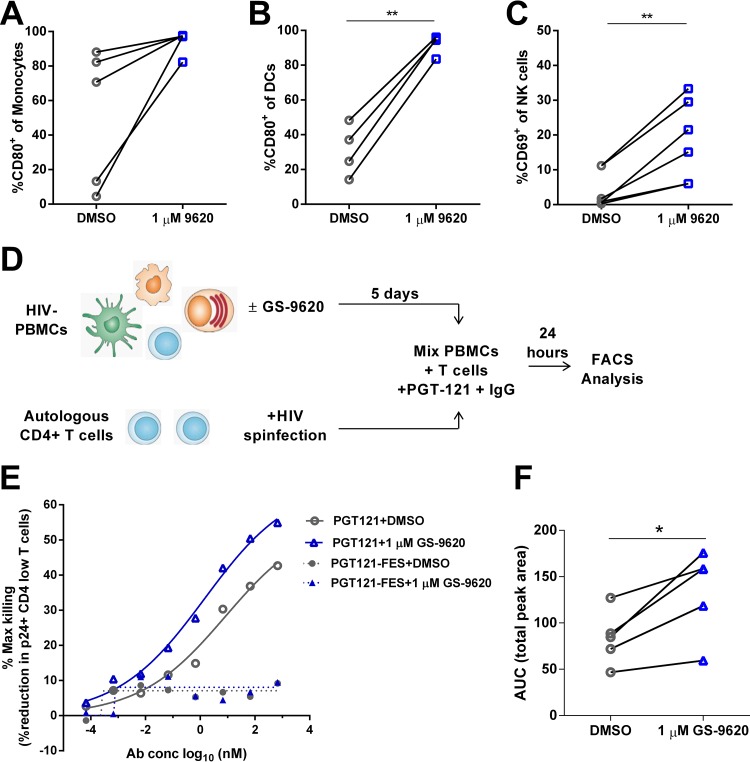
(A to C) GS-9620 activates immune effector cells and enhances PGT121 antibody-mediated killing of HIV+ CD4 cells. PBMCs from healthy donors were treated with 1 μM GS-9620 and stained for CD69 or CD80 expression on monocytes (n = 5) (A), DCs (n = 4) (B), and NK cells (n = 6) (C). (D) Schematic describing the antibody-mediated killing assay using GS-9620-treated PBMCs as effectors. Briefly, PBMCs from healthy donors were treated with 1 μM GS-9620 or DMSO and cultured for 5 days. Simultaneously, autologous donor CD4 T cells were isolated, spinfected with HIV-1 BaL, and cultured at 37°C for 5 days. On day 5, the HIV-infected CD4 T cells were mixed with titrations of PGT121 antibody and human IgG. After opsonization for 30 min, GS-9620- or DMSO-treated PBMCs were mixed in at an effector/target ratio of 20 PBMCs to 1 infected CD4 cell and incubated at 37°C overnight. The next day, the cells were stained for p24, and HIV-infected cells were quantified by fluorescence-activated cell sorter (FACS). (E) Average values from 5 donors. (F) Peak AUC from results plotted as in panel E were compared for DMSO-treated and GS-9620-treated PBMCs from each individual donor. The P values were determined by paired Student's t tests. *, P < 0.05; **, P < 0.01.